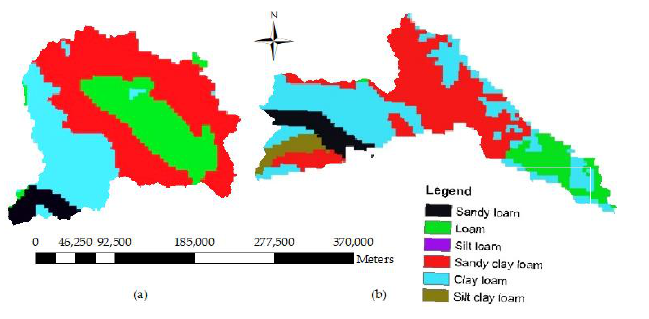
Fig. 6. FAO soil classification (a) Jhelum river basin (b) Chenab river basin